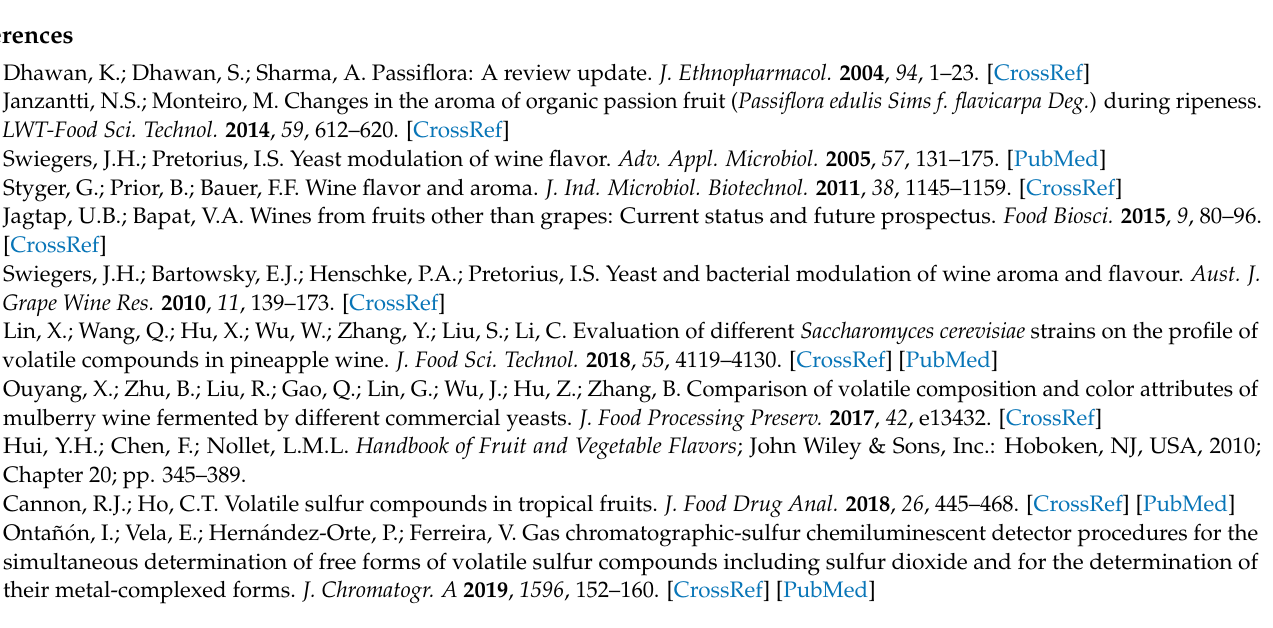
Table S1: The standard curve, validation range, LOD, LOQ, HRF score and coefficient of determina- tion (r2) for sulfur volatile compounds in passion fruit wine; Table S2: Significant differences of OAV among yeast strain ES488 (ES), BV818 (BV), VIC (VI), and CY3079 (CY); Table S3: Mean, standard deviation value and Tukey’s test of sensory